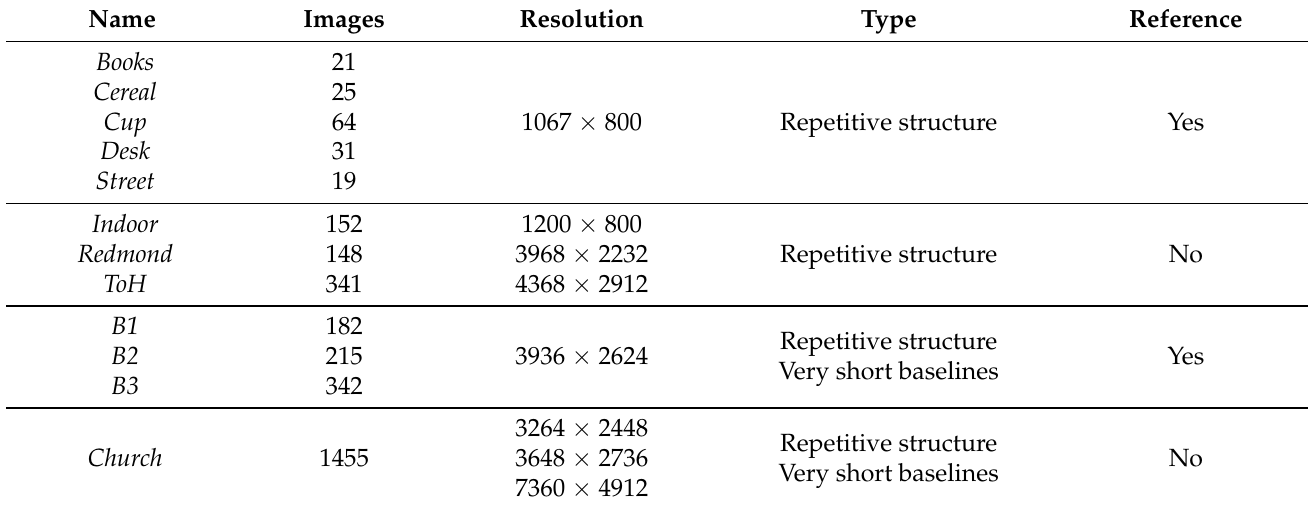
Table 2. The description of image datasets used in our